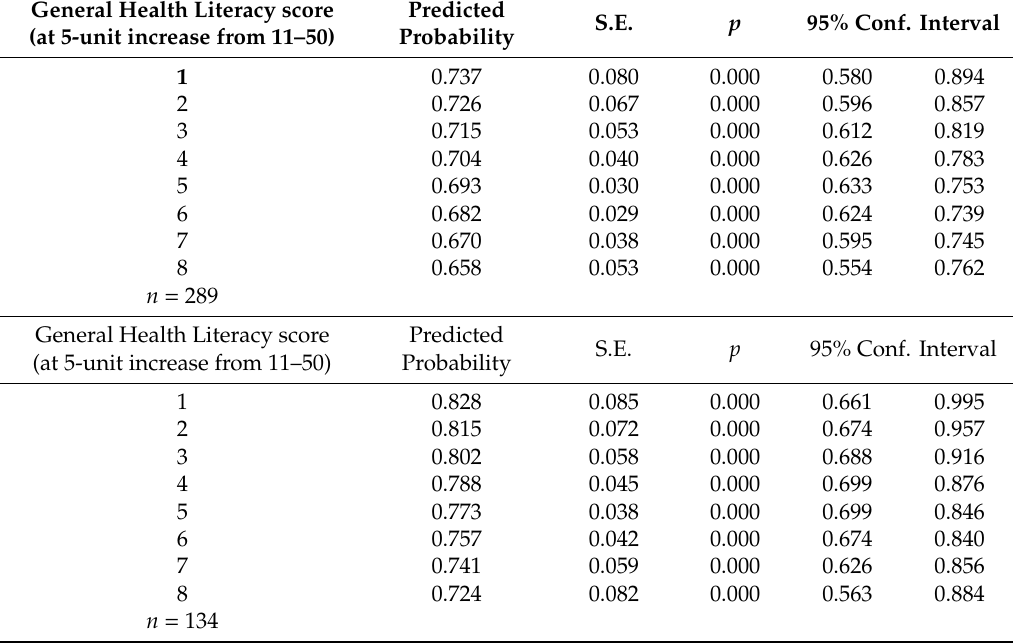
Table A3. Longstanding health